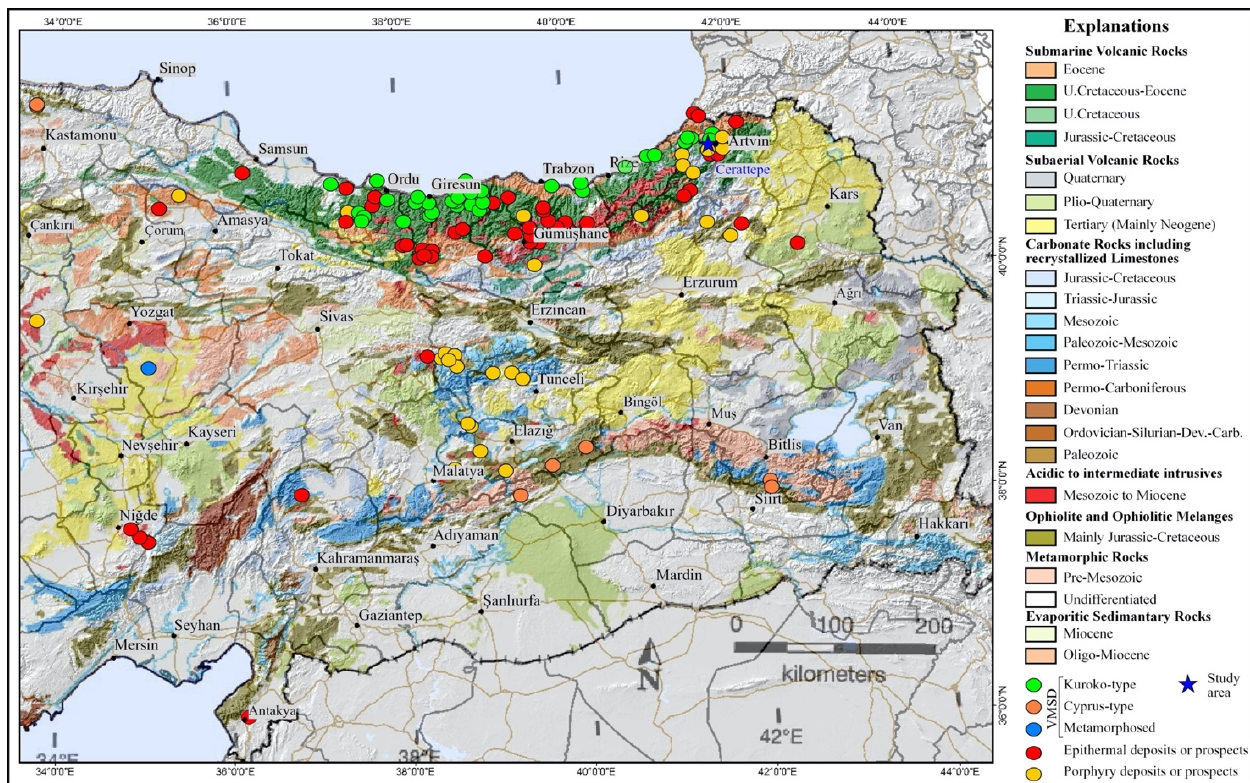
Figure 1. Geological map with continuous SRTM topography surface and distribution of the VMS, Epithermal, and porphyry deposits and prospects of Central-Eastern Turkey with emphasis on host rock lithology. Geology and location of deposits are from [17].